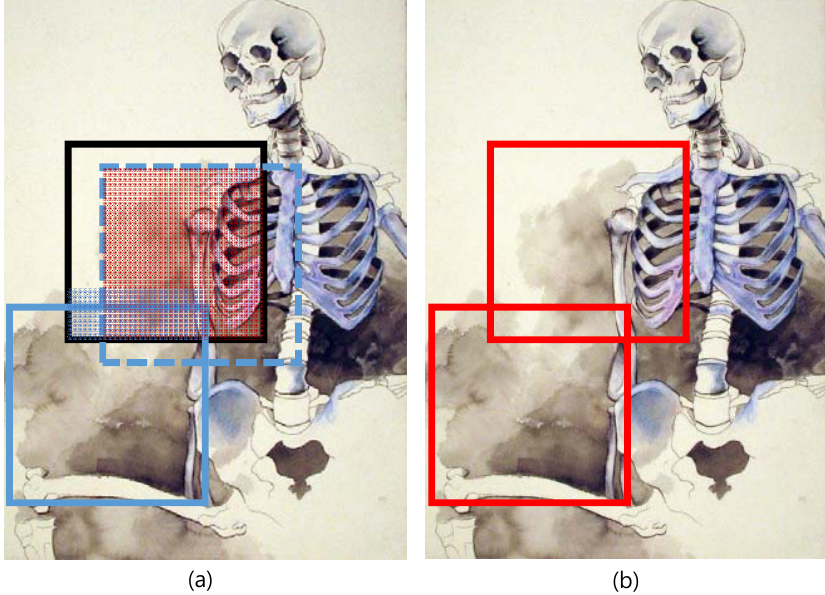
Figure 9. Excluding overlapped patches: ( a ) The black patch is a captured gtPatch. The dashed patch is a patch of next mode. But, it is excluded, since it is overlapped with the black gtPatch. The realline patch is captured next. ( b ) The two gtPatches.